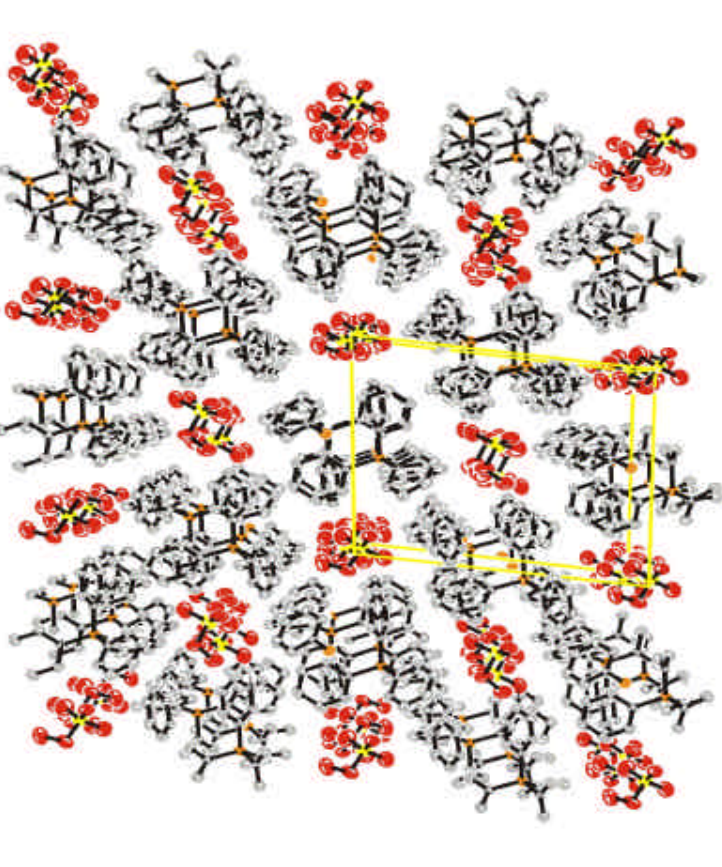
Figure 2. Packing mode in the X-ray structure of ( 4 ) as viewed down the c